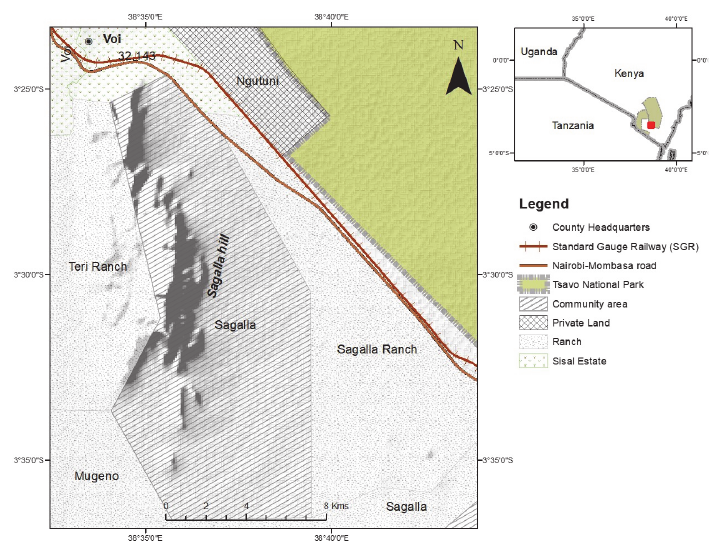
Figure 1. The study area chosen for this research is located East of the Sagalla hill, in the naturally vegetated area within the Sagalla community area and the Sagalla ranch, South of the Standard Gauge railway and the Nairobi -Mombasa major highway. This study region is situated between the Tsavo East and Tsavo West national parks, a key area for wildlife migrating between the parks beyond the park fences.